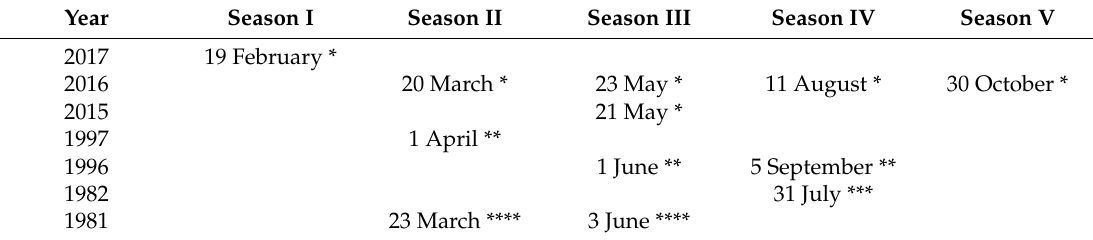
Table 1. Landsat satellite images used in the study.